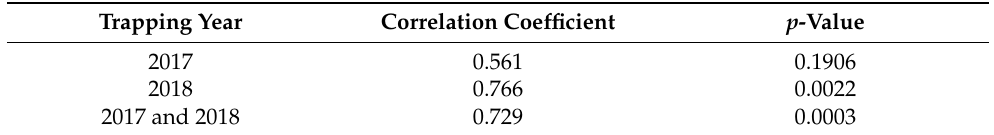
Table 3. The correlation coefficient for the relationship between mean daily temperature and Rhyzop- ertha dominica captures among all locations and attractant types during 2017, 2018, and the combined